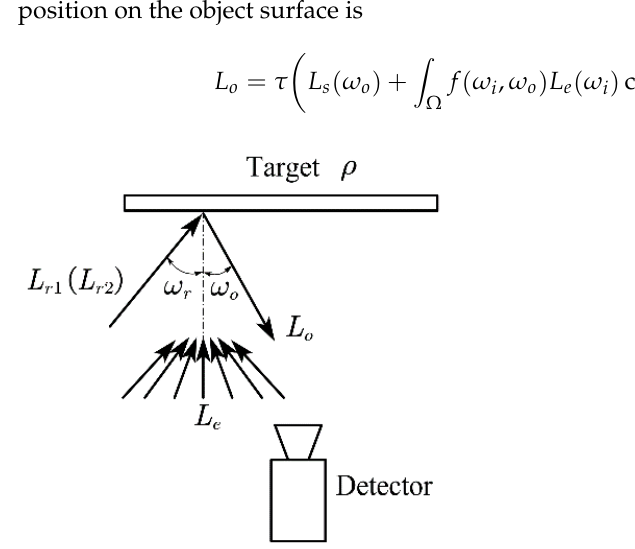
Figure 5. Radiation received by the detector from a planar object.